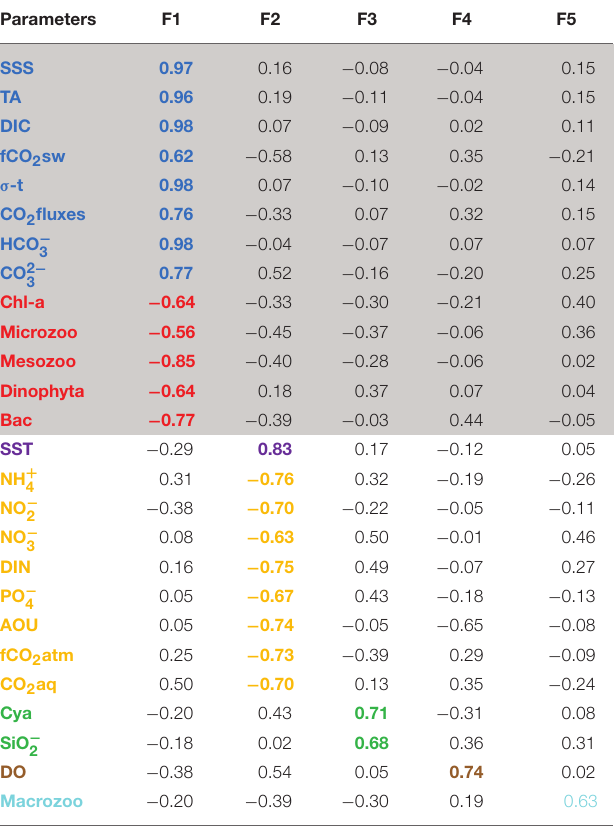
TABLE 1 | Loading factors of the 5 principal components (PCA analysis).